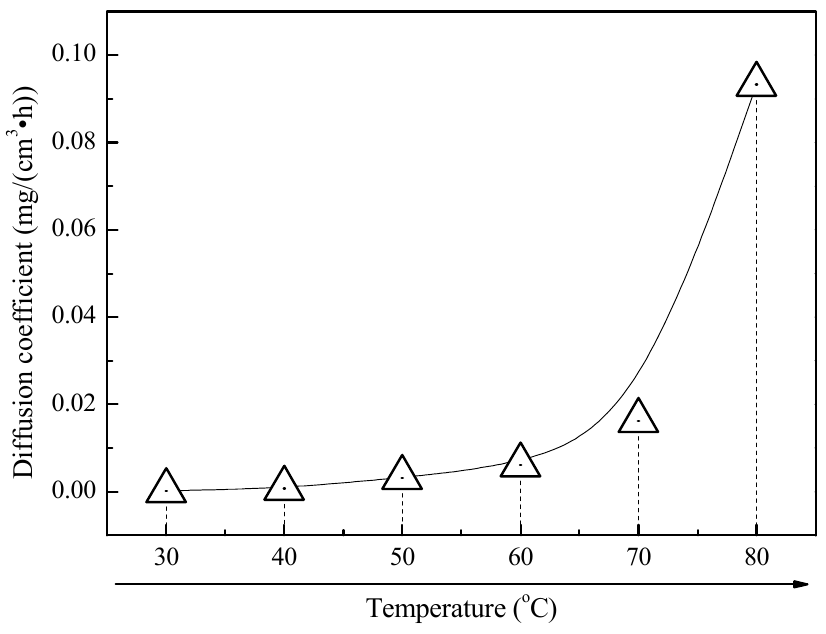
Figure 12. Trend chart of the relationship between the diffusion coefficient and temperature.